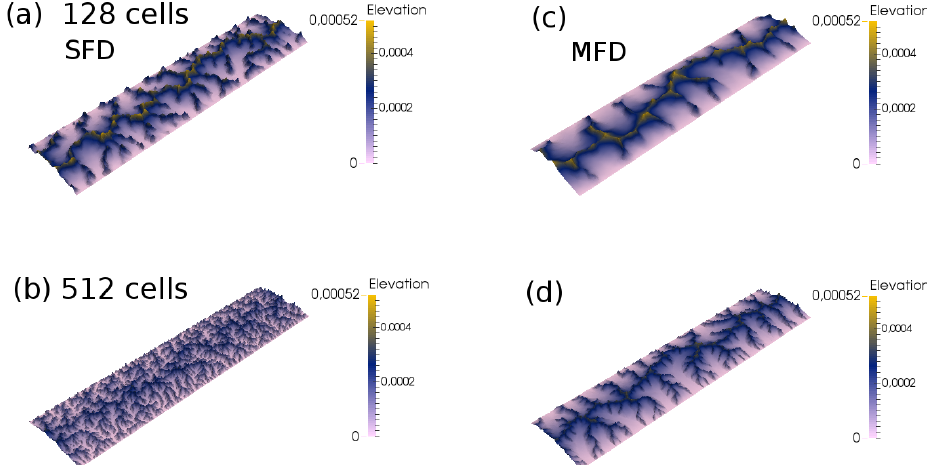
Figure 4. Dimensionless elevation from the node-to-node flow routing landscape evolution model with different flow routing algorithms at different numerical resolutions after a dimensionless runtime of 1 . 563 × 10 − 6 (5Myr), with an aspect ratio of 4 × 1. (a) Node-to-node single flow direction (SFD) algorithm with a resolution of 512 × 128 cells. (b) The same model but with a resolution of 2048 × 512 cells. Panels (c) and (d) : node-to-node multiple flow direction (MFD)